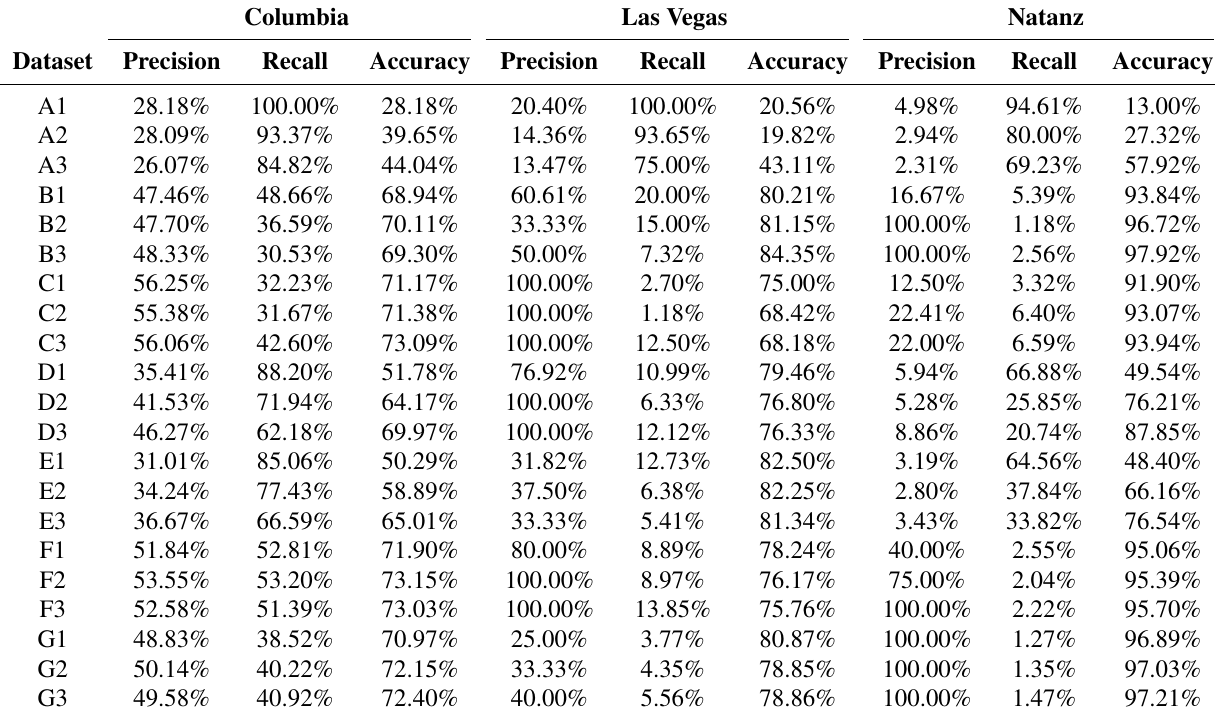
Table 11. Random forest change prediction